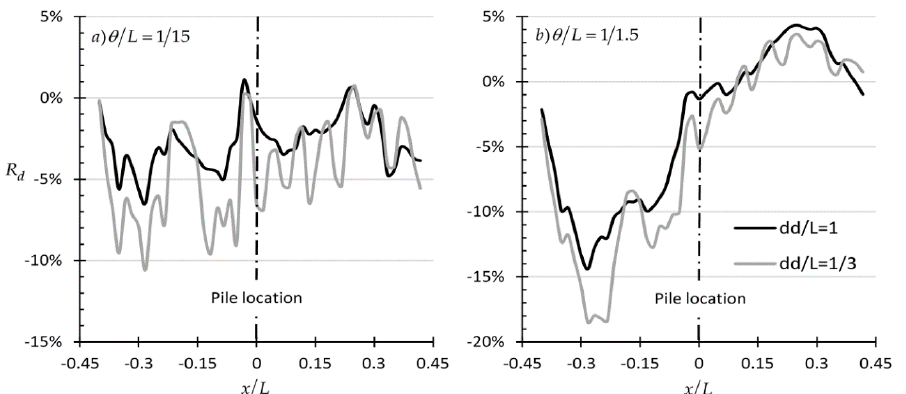
Figure 12. Relative difference R d (=Λ/Λref-1; recall Equation 3) versus x/L (relative distance from the pile location) for ( a ) θ / L = 1/15 and ( b ) θ / L = 1/1.5. Charts drawn using characteristic friction angle values.